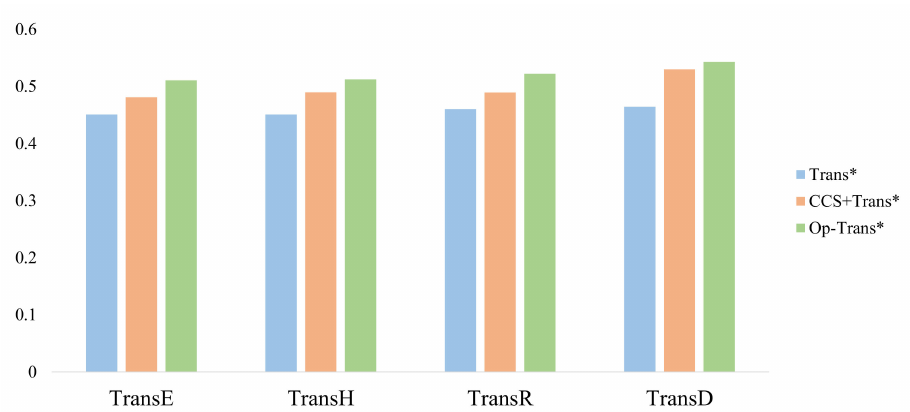
Figure 9. Hits@10 values for the three methods on the dataset WN18RR, ■ indicates initial model, ■ indicates CCS negative sample, ■ indicates Op‑Trans framework, * is denoted as various baseline models.